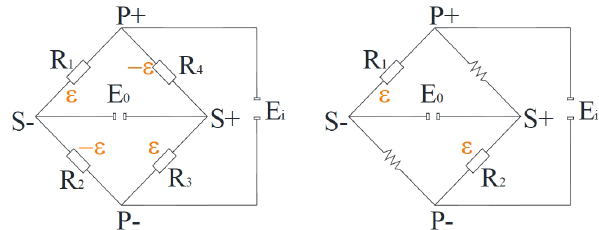
3 Finite element analysis of the elastic wheel type element with